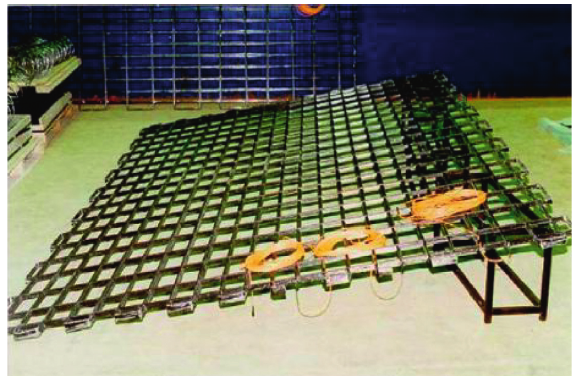
Figure 3: Overview of FRP grids